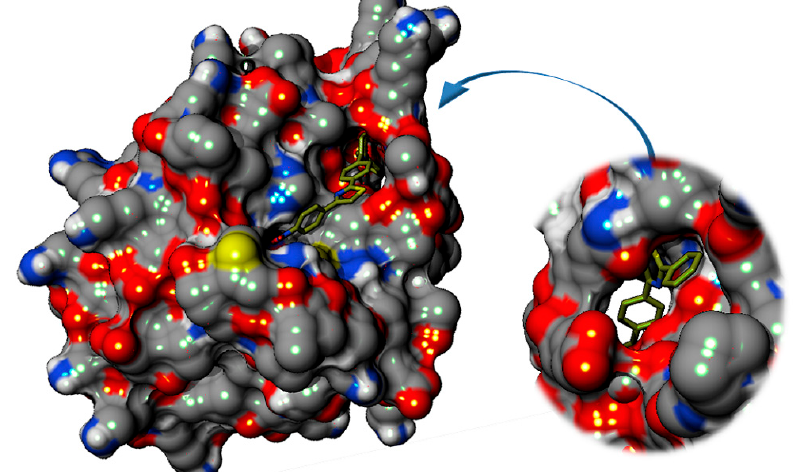
Figure 7. 3D-surface representation of the predicted binding mode of C1 – 8 to the active site of E. faecalis Sortase A (EfSRT_29212). All compounds cause a steric hindrance that prevents access to the catalytic AA triad while binding is strengthen by the two distal claws that enclose the compounds.